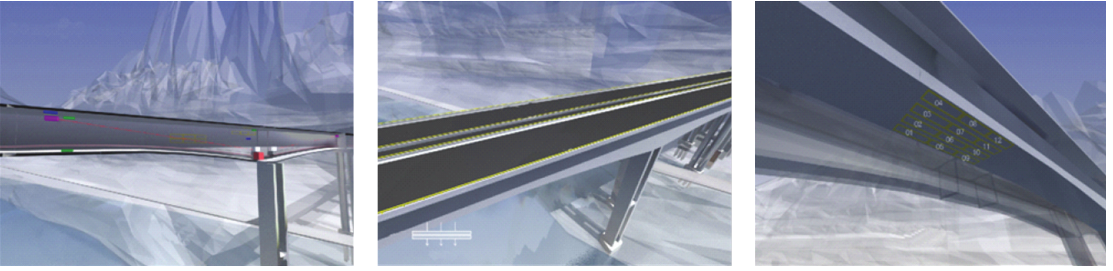
Figure 17: Effect of the interactive 3D